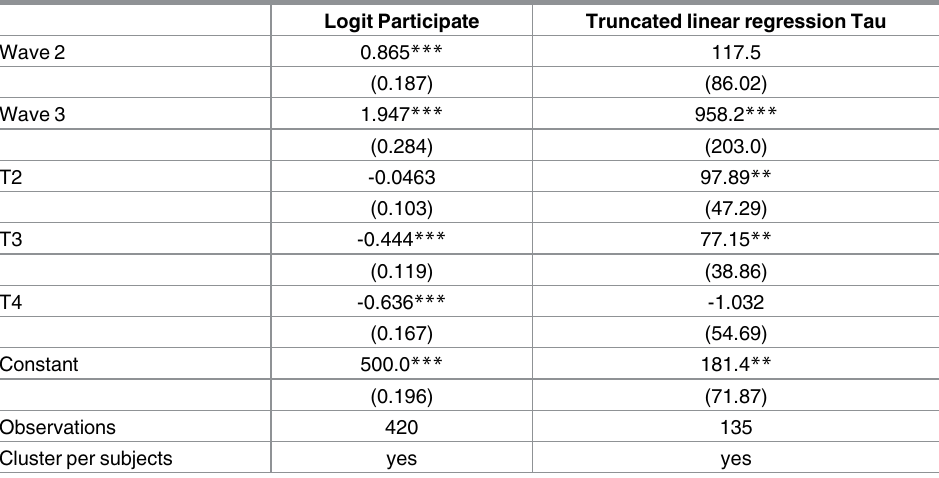
Table 4. Hurdle model on the amount taken from player B.